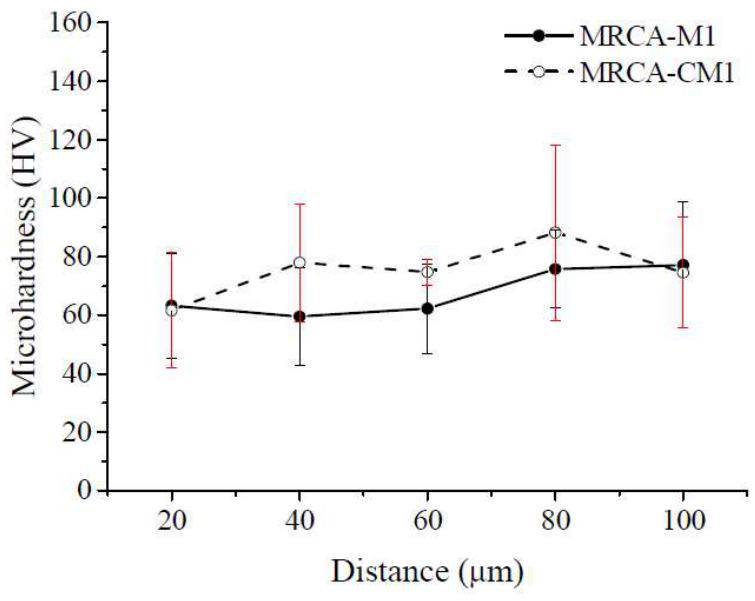
Figure 20. Microhardness test [45]. Reproduced with permission from [45], Elsevier, 2018.